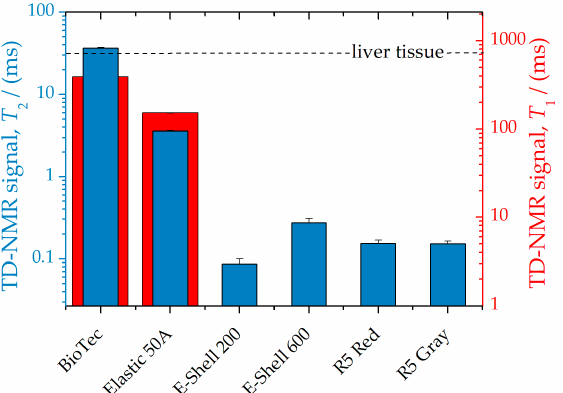
Figure 3. TD-NMR relaxation times T 1 (red) and T 2 (blue) were measured by TD-NMR of the cylindrical samples. The horizontal line denotes the T 2 = 31 ms and T 1 = 745 ms of liver tissue [27]. For T 2 determination of BioTec and Elastic 50A samples, a double-exponential fit function was applied and the slower relaxation time was plotted as found previously by [28]. T 1 relaxation values for E-Shell and R5 samples were not measurable with the TD-NMR relaxometer. Table 1. Summary of the material selection procedure. A ranking is presented for each investigated property (I: best suitable, II: questionable suitability, III: unsuitable). The number in the parenthesis indicates the uncertainty in the last